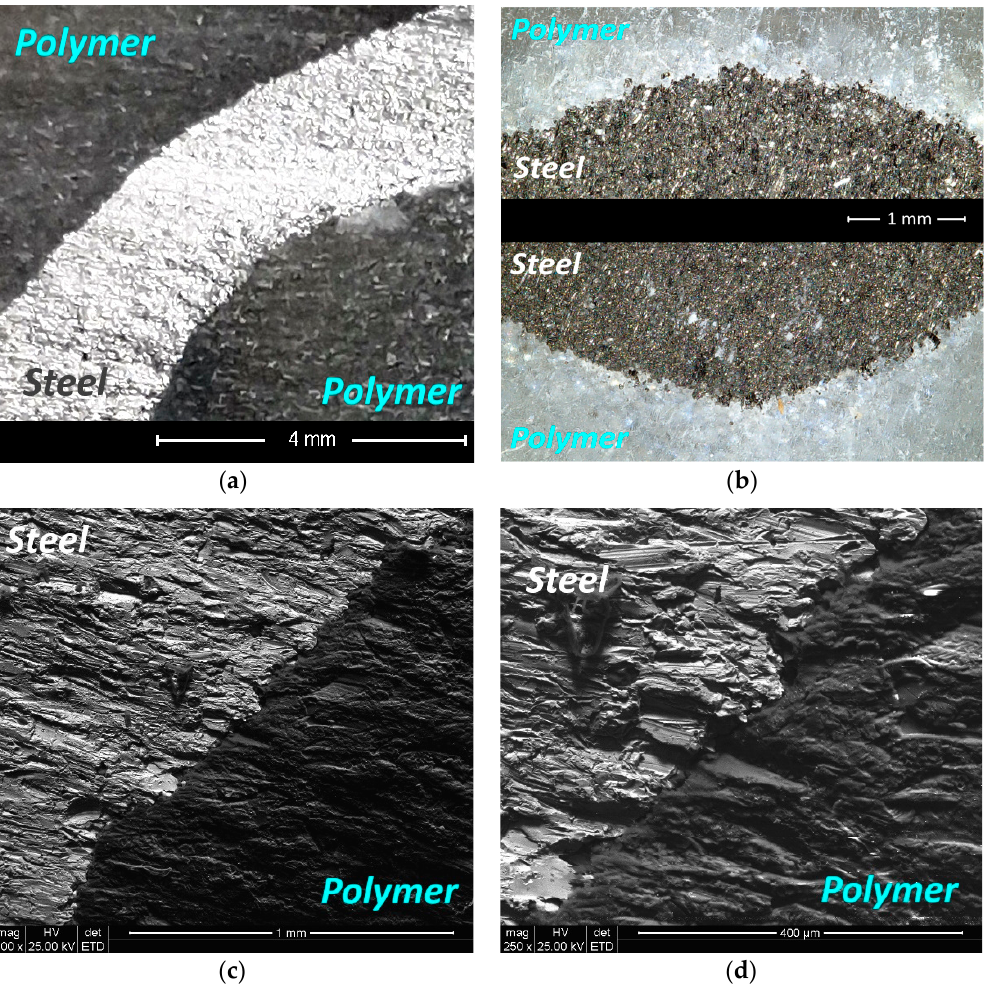
Figure 8. A sample of cut surface: ( a ) the optical microscope view, ( b ) the detailed optical microscope view x80, ( c ) the SEM microscope view ×100, and ( d ) the SEM microscope view ×250.